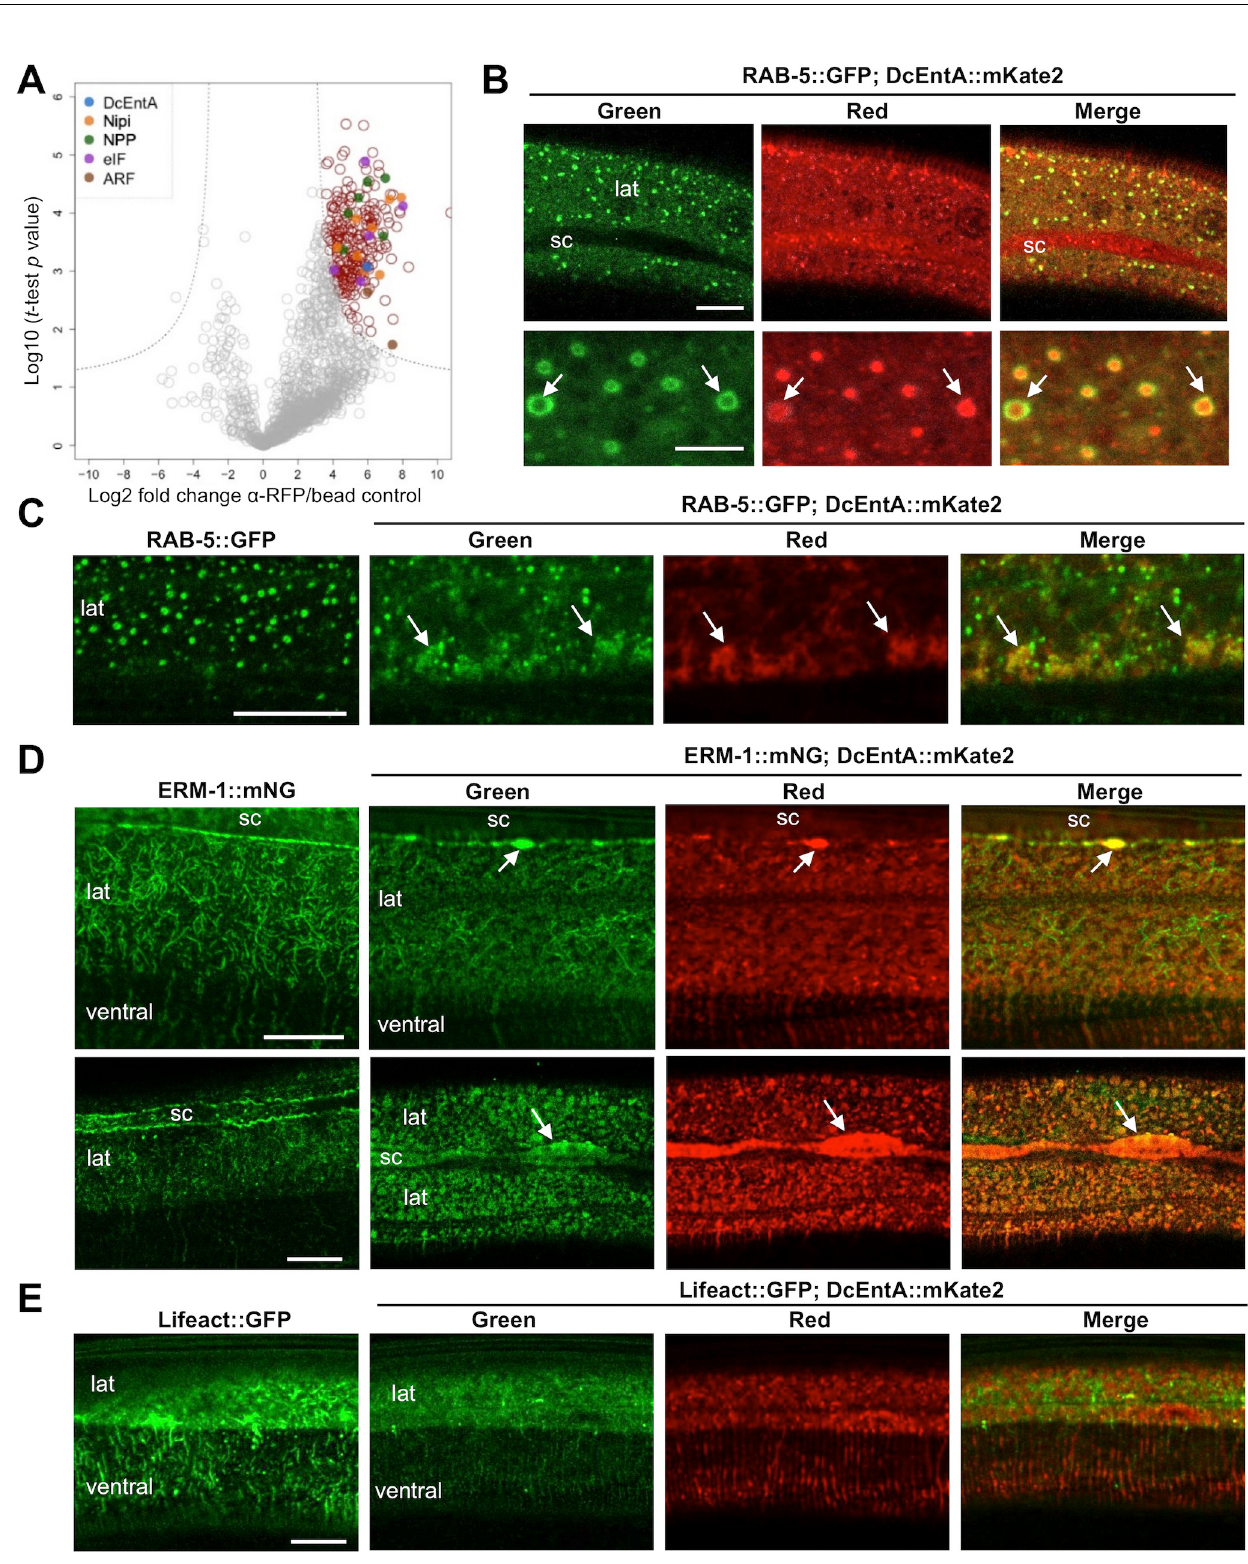
Fig 6. DcEntA interacts with many candidate host proteins and disrupts endocytosis and the host cytoskeleton. ( A ) The relative abundance of proteins co-precipitated with DcEntA::FLAG::Degron::mKate2 was assessed by mass spectrometry. Volcano plot showing specific interaction partners (in red) of DcEntA::FLAG::Degron::mKate2 (DcEntA in blue). The mean values for fold change from 3 independent experiments are shown. The SAM